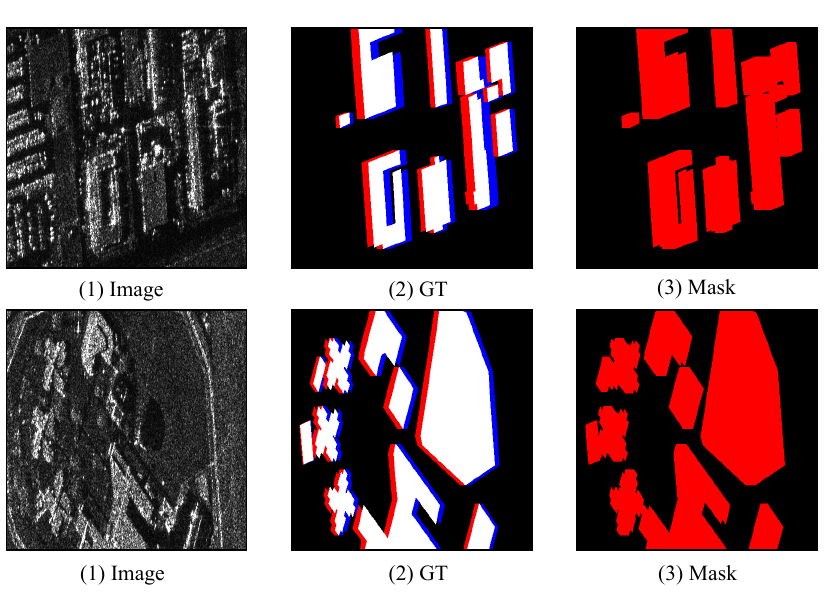
Figure 7. Examples of the original dataset and some results